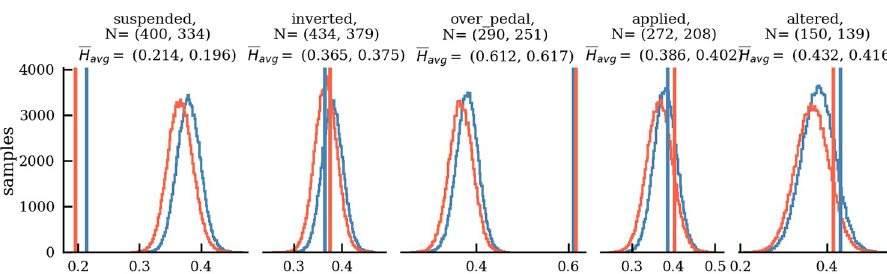
Fig 7. Entropies based on chord features. Average normalized conditional entropies � H certain feature (vertical lines) for major (blue) and minor (red) compared to bootstrap samples of the same size N (histograms) under the null hypothesis. Subfigures display the different features suspensions and added notes (“suspended”), inversions (“inverted”), chord over pedals (“over pedal”), applied chords (“applied”), and chords with altered roots (“altered”). The first number in parentheses refers to the major mode, the second number to the minor